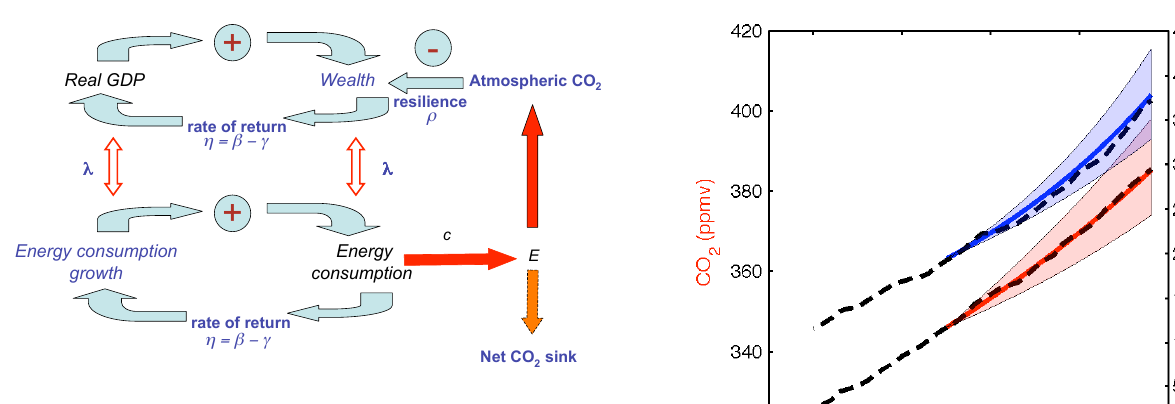
Fig. 4. Schematic illustrating the CThERM framework for economic growth (Garrett, 2011), coupled to atmospheric CO 2 concentrations. Global rates of primary energy consumption rates a are tied to accumulated inflation-adjusted global economic wealth C = R t 0 Pdt 0 through a constant coefficient λ =9.7 milliwatts per 1990 dollar. Because λ is a constant, growth in energy consumption rates da/dt are represented economically by the real, inflation-adjusted global GDP P . Thus, da/dt = λP determines the “rate of return” η = d ln η/dt adding to a = λC . E represents the anthropogenic rate of CO 2 emissions, β is the source for a positive rate of return η due to increasing availability of energy reservoirs. γ is the sink for civilization growth driven by environmental degradation. Emissions E determine CO 2 concentrations, subject to land and ocean sinks. CO 2 concentrations act as a negative feedback on economic growth.